Question: According to this chart, does the measure grow or shrink?
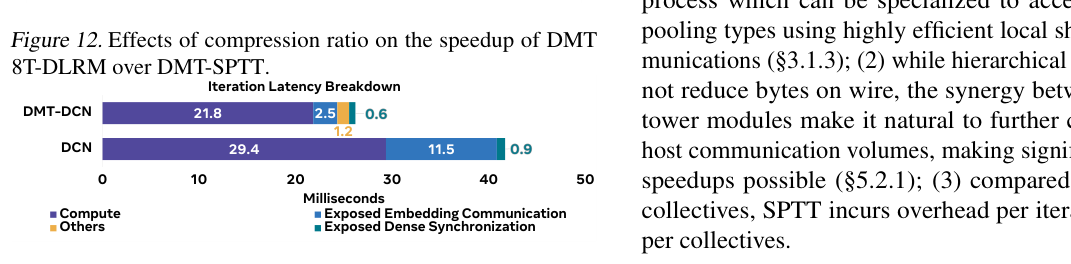
Answer: increasing